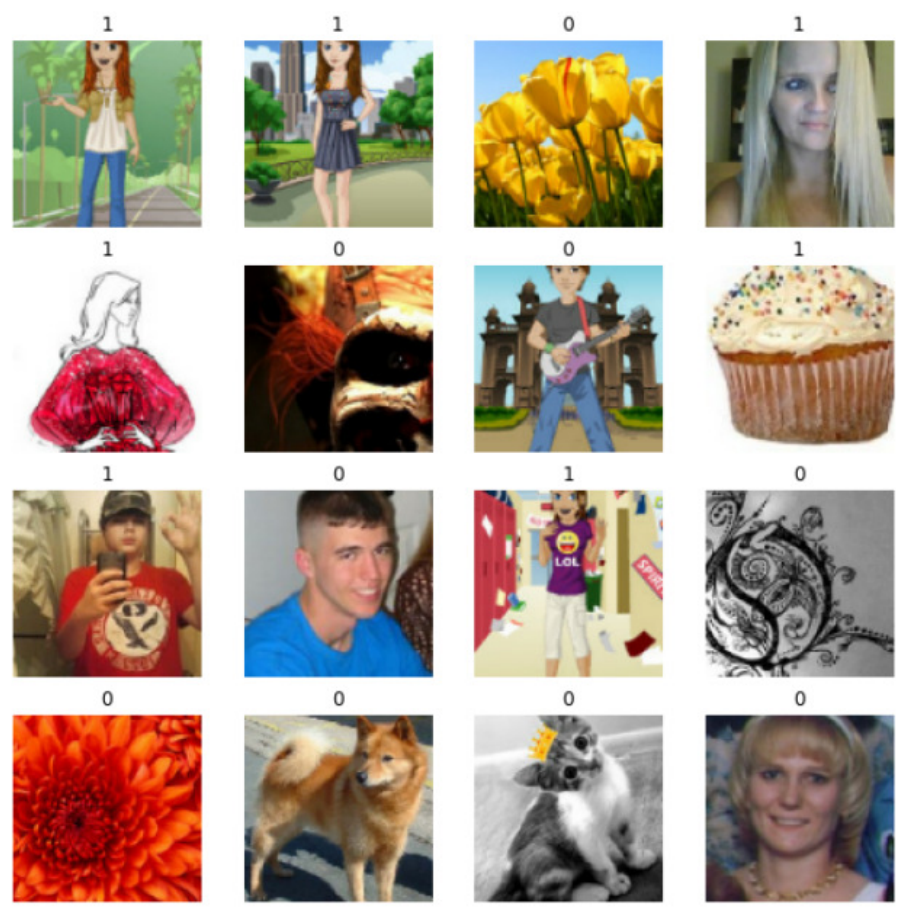
Figure 11. Original samples. The labels 0 and 1 indicate the classes Gen Z and Y,